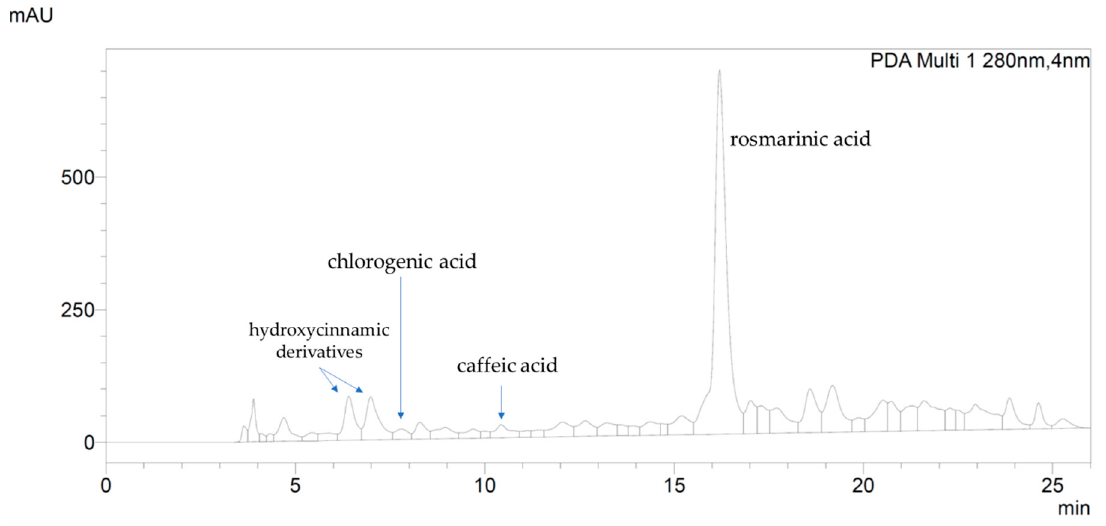
Figure 1. HPLC-DAD analysis of Ro ex recorded at 280 nm. Rosmarinic acid is the phenolic compound of the extract with the highest content; other hydroxycinnamic derivatives are present in high